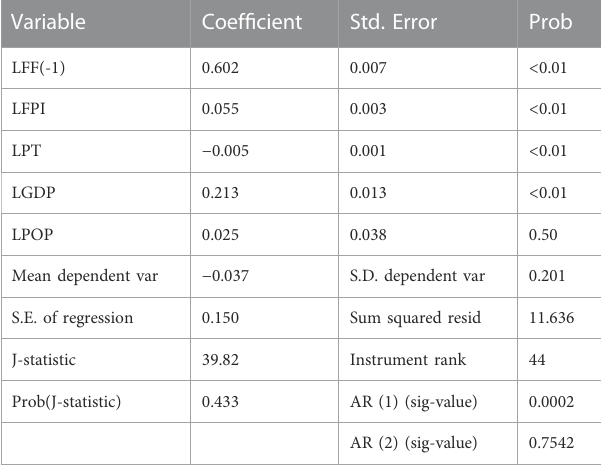
TABLE 5 Estimation results of System GMM model.